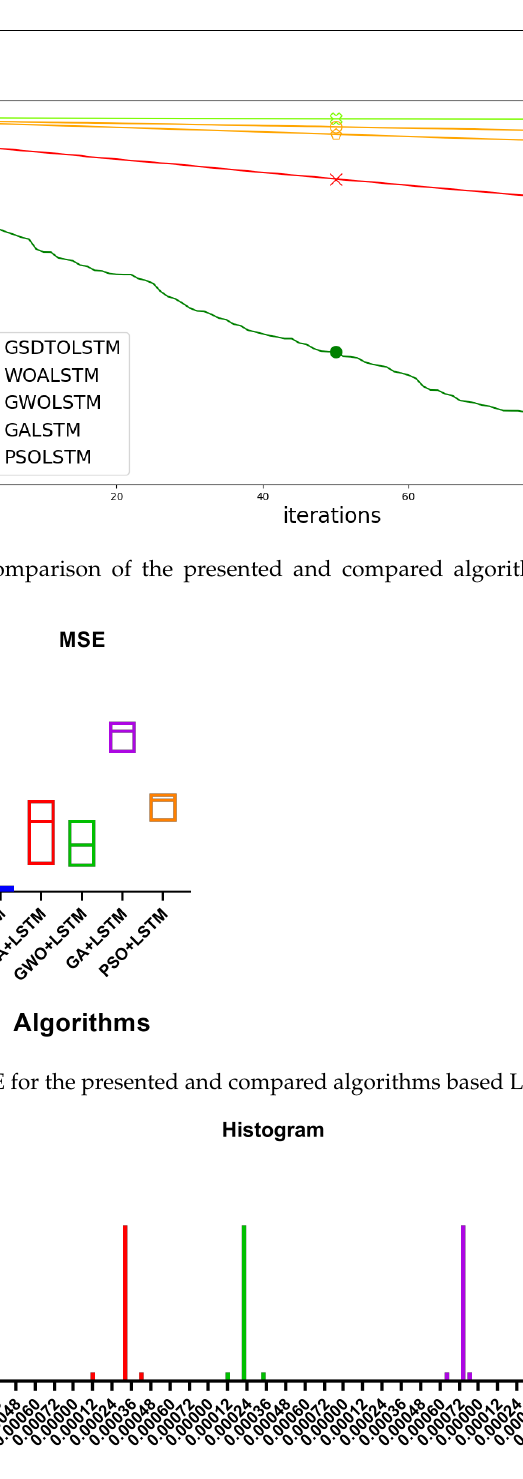
Figure 9. Histogram for the presented and compared algorithms based LSTM